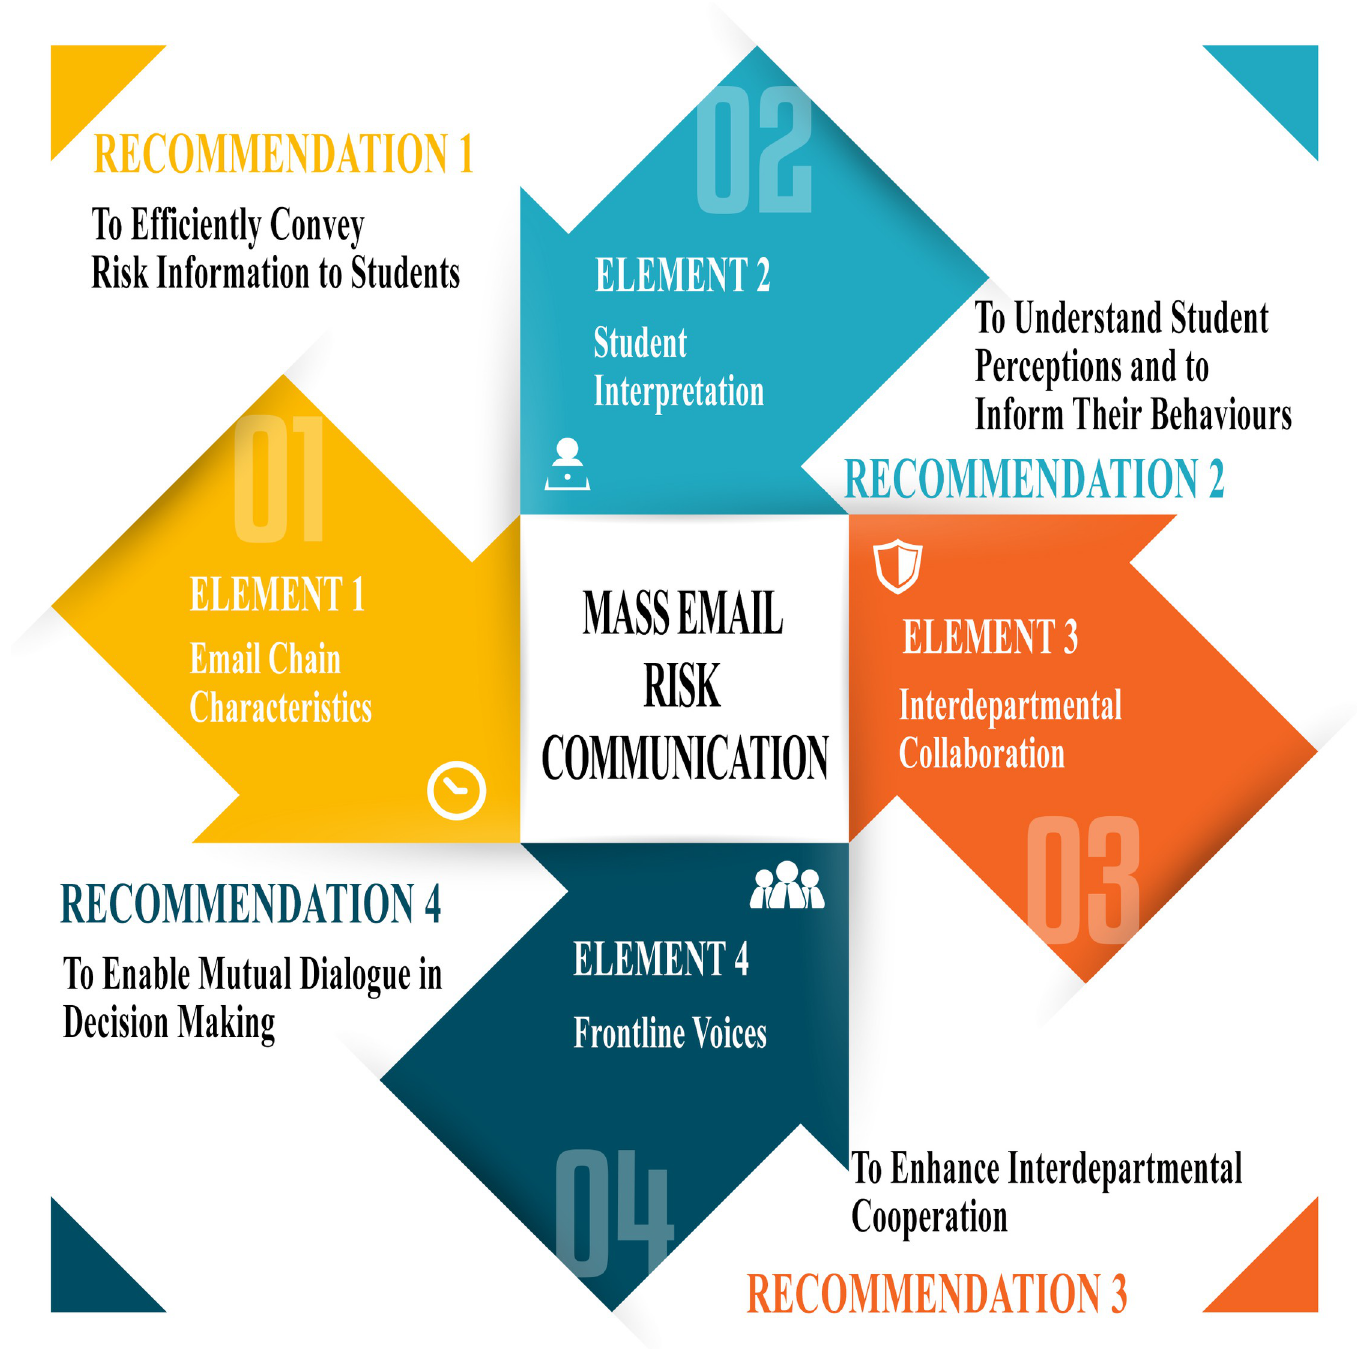
Fig 2. Mass email risk communication: Elements and recommendations. The arrows present the four themes from the finding section. In responding to each theme, a recommendation was developed.